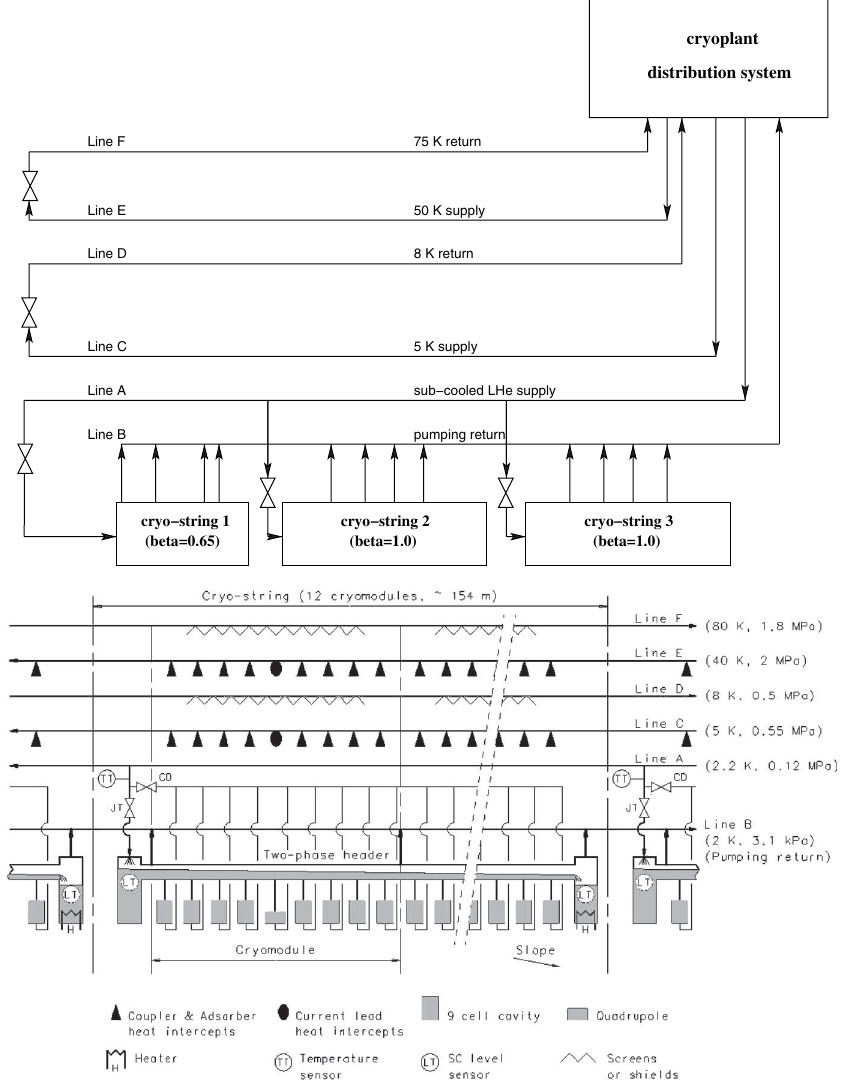
FIG. 17. Possible cooling scheme (published in [44]).